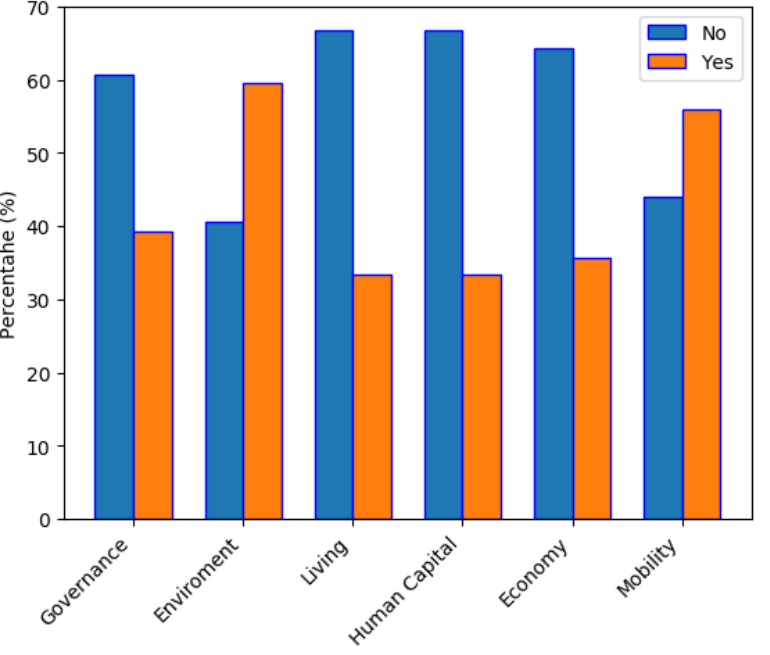
Figure 4. Areas for improvements in your